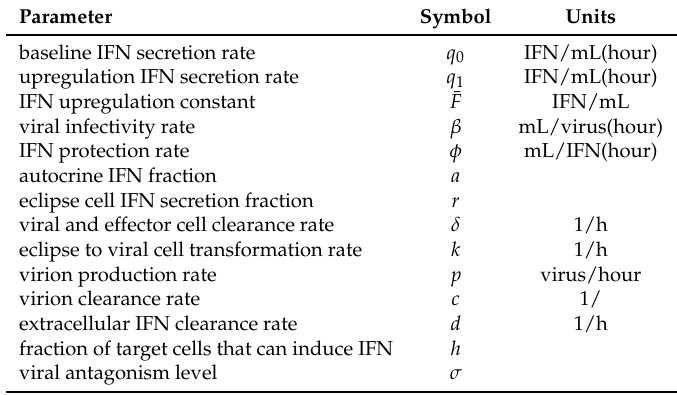
Table 2. Model parameters Units for IFN varied between datasets: Schmid et al. (IFN-lambda, pg/mL), Rand et al. (IFN-beta, U/mL), Saenz et al. (IFN-alpha, mRNA/mL), Patil et al. [47] (IFN-beta,